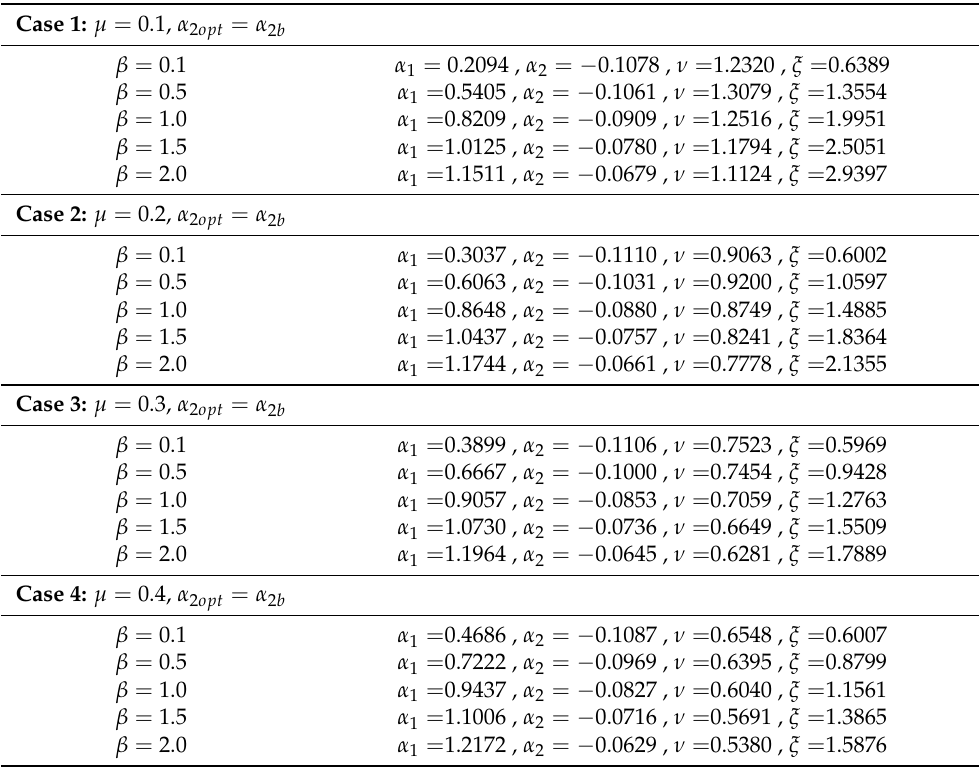
Table 1. The specific parameters of the system with different inerter-to-mass ratios in initial optimiza- tion ( α 2 opt = α 2 b